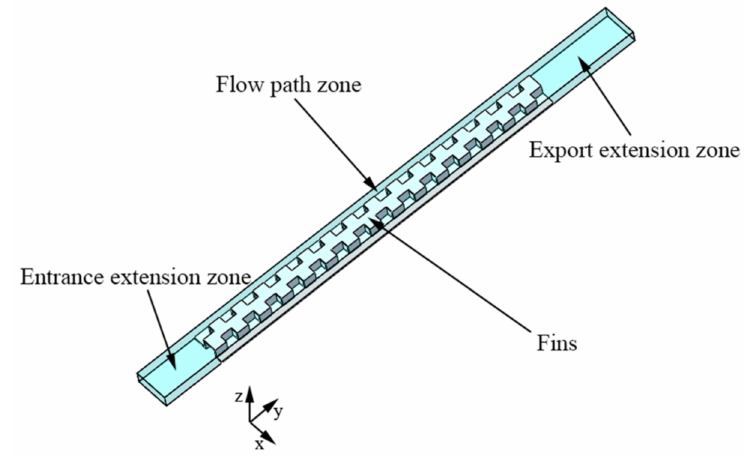
Figure 1. The airside unit model. The simulation results are fitted to the velocity pressure drop curve as shown in Figure 2.